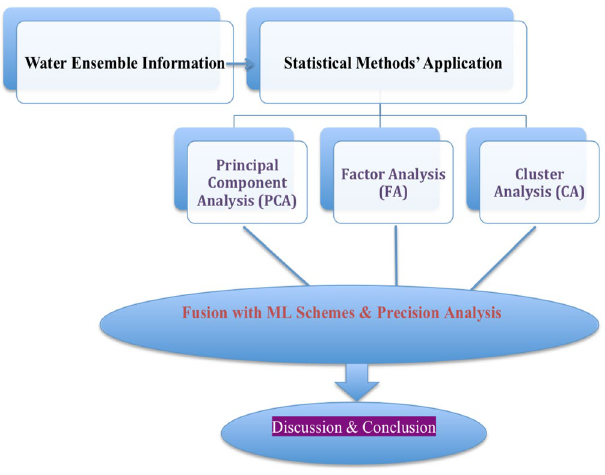
Figure 1. Study flow chart.